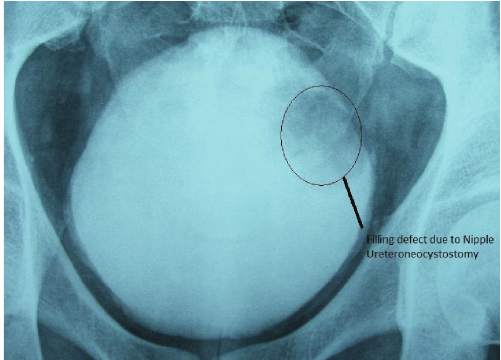
Figure 4: Postoperative voiding